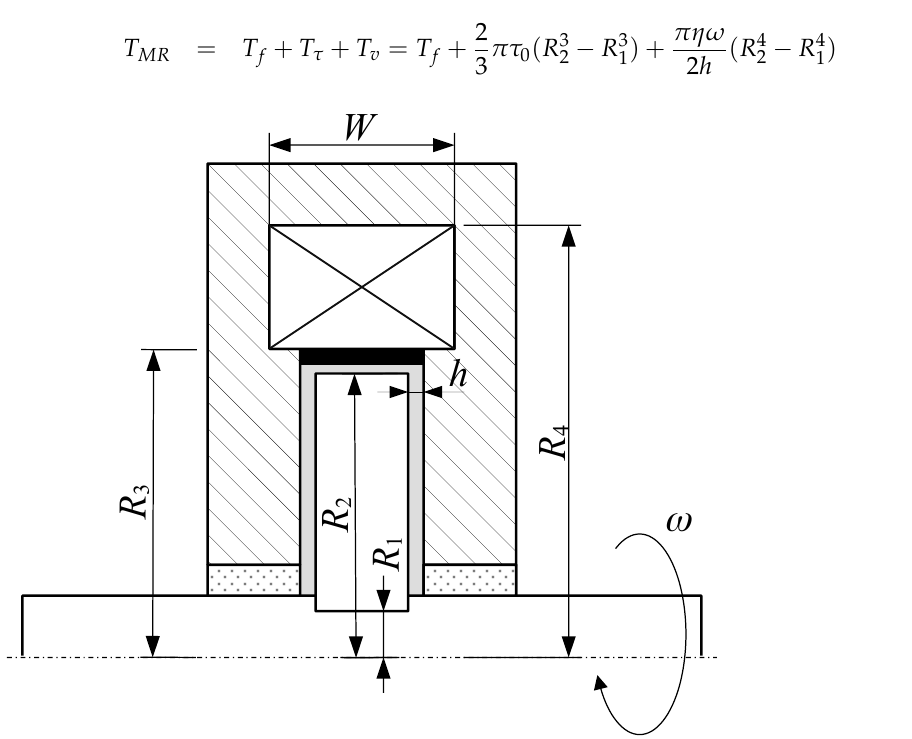
Figure 2. MR rotary damper dimensions: R 1 , R 2 —shear plate internal (external) radius, R 3 , R 4 — internal (external) radius of the coil window, h —gap, W —coil window width, H = R 4 − R 3 —coil window height.